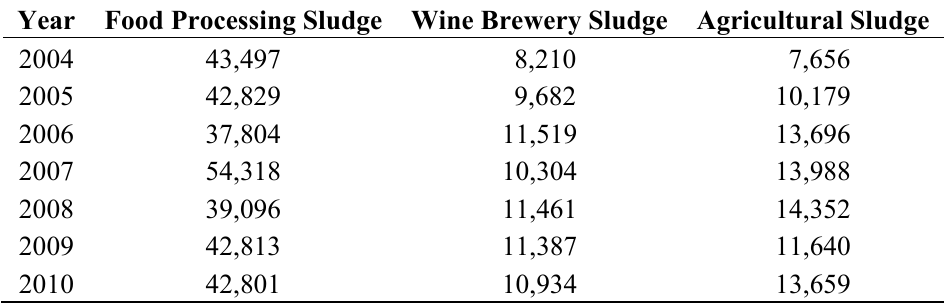
Table 2. Statistics on the reported amounts of dewatered biosludge for reuse in Taiwan a